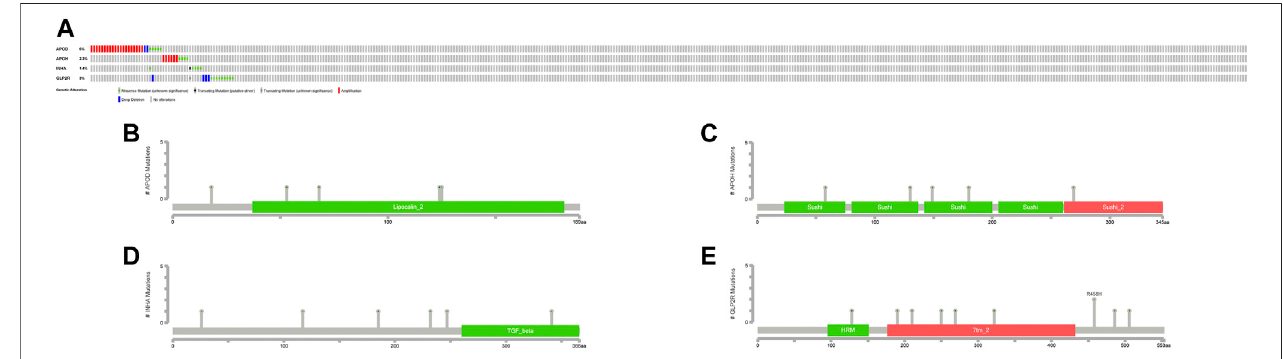
Frontiers in Cell and Developmental Biology |